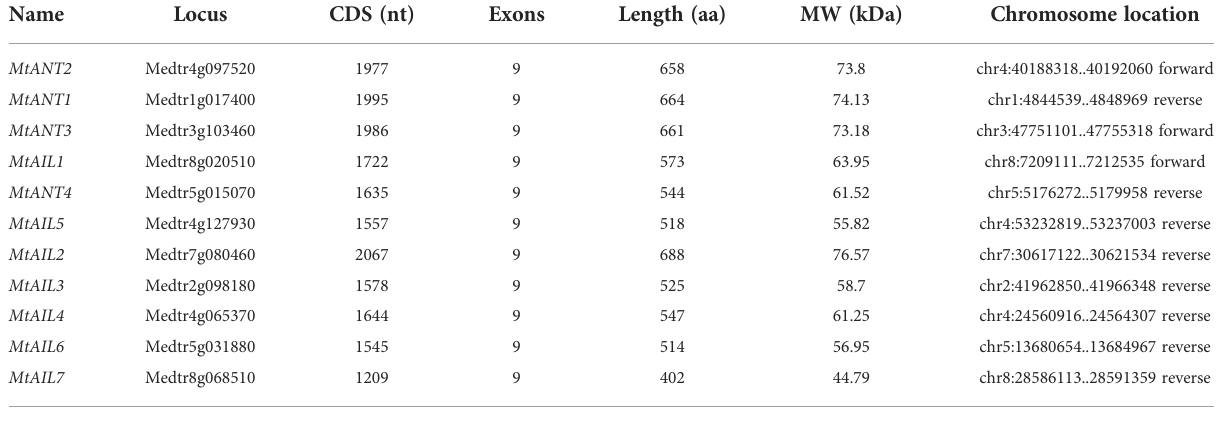
TABLE 1 AIL gene family in M. truncatula .